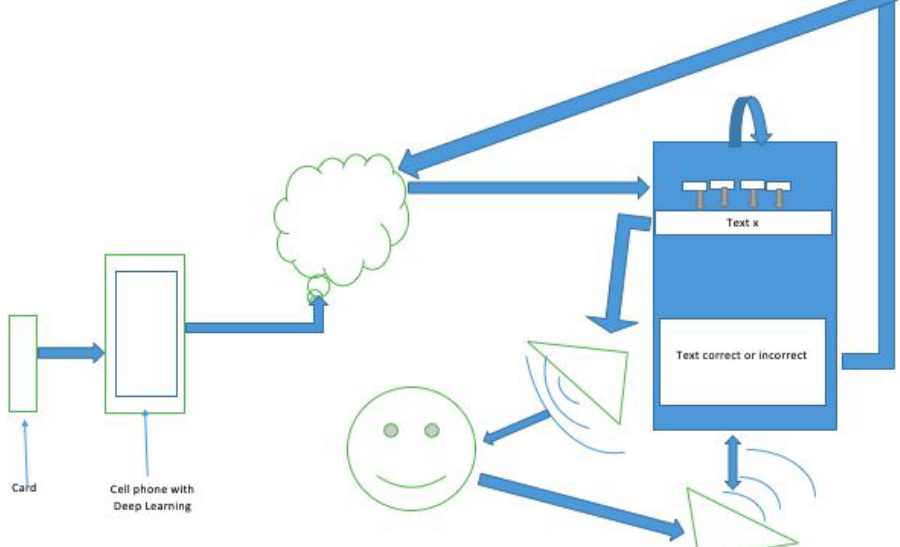
Figure 3. System Design for a graphical